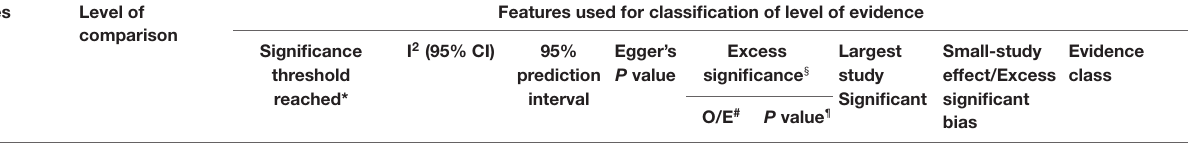
TABLE 2 | Level of evidence for the association of sleep duration/quality for health outcomes.